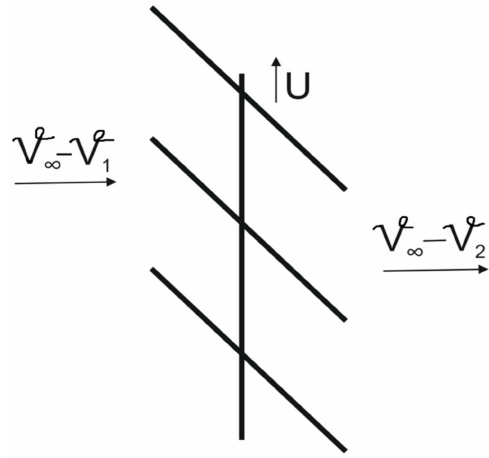
Figure 3. Diagram of the grid